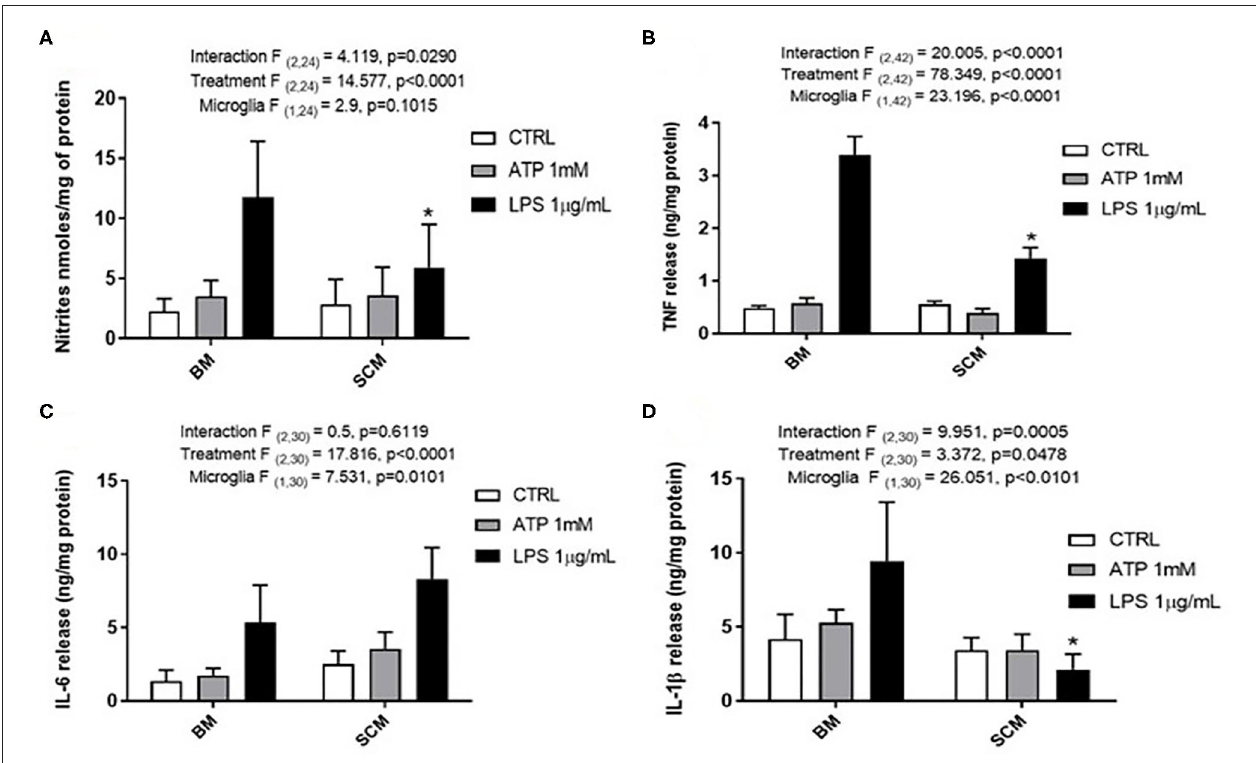
FIGURE 1 | Release of the pro-inflammatory effectors by ATP activated BM and SCM. (A) Two-away ANOVA identified significant interaction between microglia and treatment for NO and a main effect of treatment for NO. However, Sidak post-hoc test revealed a significant difference between BM LPS and SCM LPS, * represents p < 0.05, n = 5, where n represents the number of independent experiments (an independent experiment is a separate microglia preparation). (B,C) Two-away ANOVA identified significant interaction between microglia and treatment TNF and IL 6. TNF released had a significant difference between BM LPS and SCM LPS was revealed by the Sidak post-hoc test, * represents p < 0.05, n = 8 for TNF and n = 6 for IL6. (D) Two-away ANOVA identified significant interaction between microglia and treatment for IL-1 β and a significant main effect of microglia. A Sidak post-hoc test revealed a significant difference between BM LPS and SCM after LPS treatment. * represents p < 0.05 for comparison, n = 6. ATP treatment did not induce a significant difference in the release of inflammatory factor NO, TNF, IL 6, IL − 1 β between BM and SCM ATP treatments. Bars represent mean ± s.e.m.